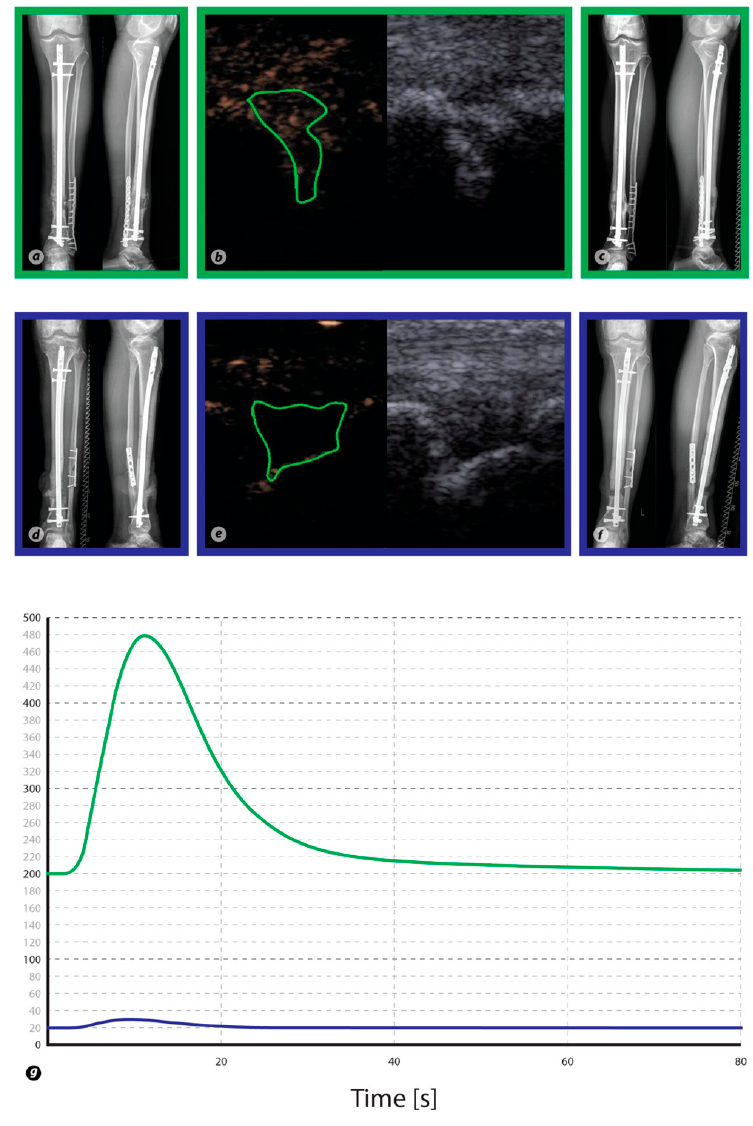
Figure 2. Conventional X ‐ rays of the tibia and fibula as well as ultrasound images are shown for two patients. In particular, images in green rectangles derive from a Responder to the therapy, whereas images in blue rectangles derive from a Non ‐ Responder. Panel ( a , d ) was taken prior to